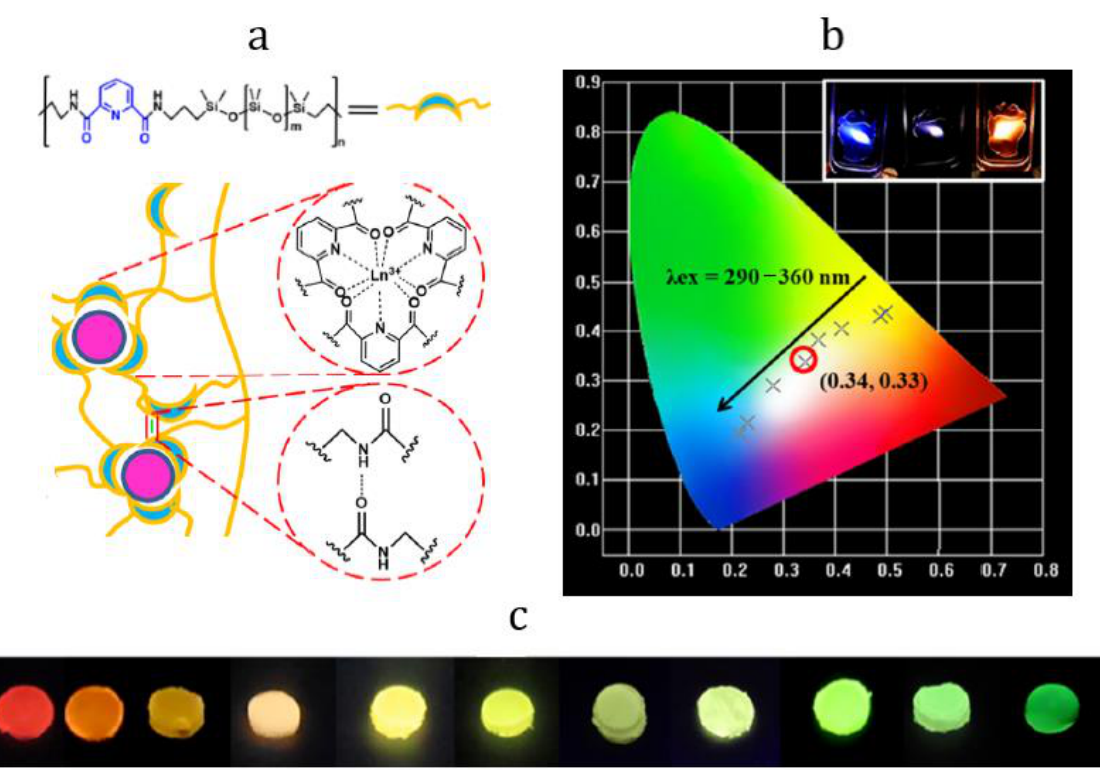
Figure 10. Schematic depiction of Ln − Py − PDMS and molecular structure of Py − PDMS ( a ), CIE 1931 color space ( b ), and optical photographs of Tb − Py − PDMS- and Eu − Py − PDMS-based phosphors ( c ) [20].